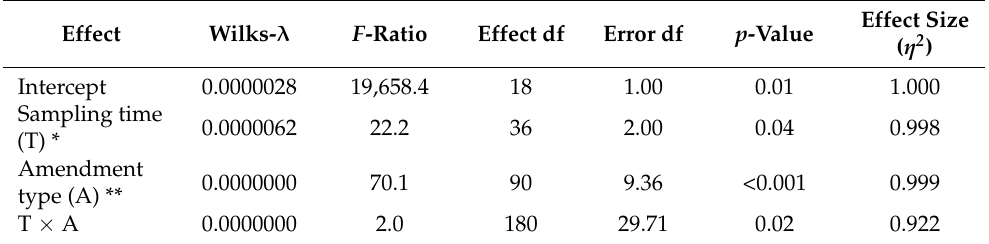
Table 4. Multivariate GLM results examining the effect of amendment type and sampling time on nematode assemblage